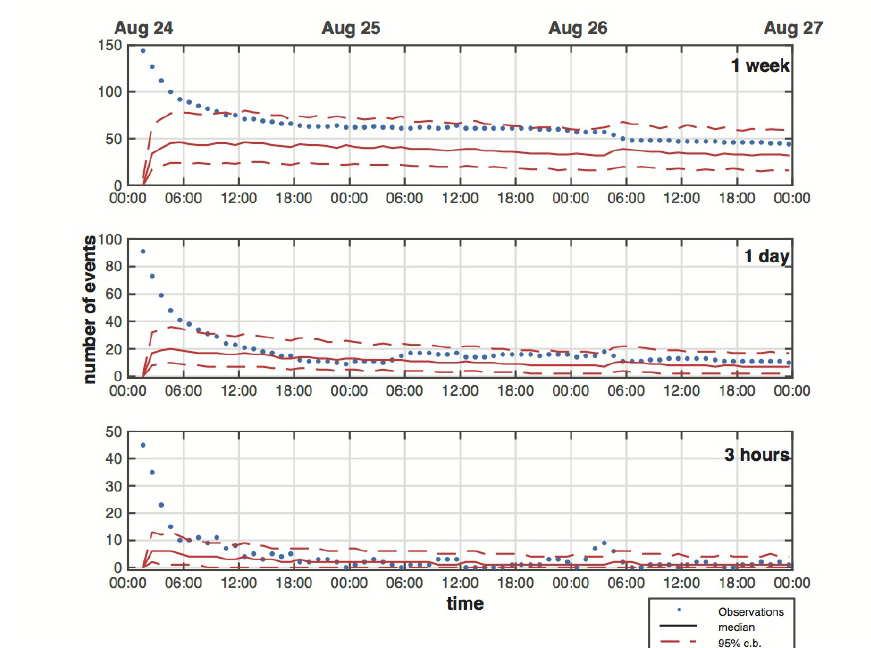
Figure 3: Comparison between the observed and the expected number of events for M F = 3.0 and for interval times of 1 week, 1 day and 3 hours for the first 3 days of the sequence (Aug